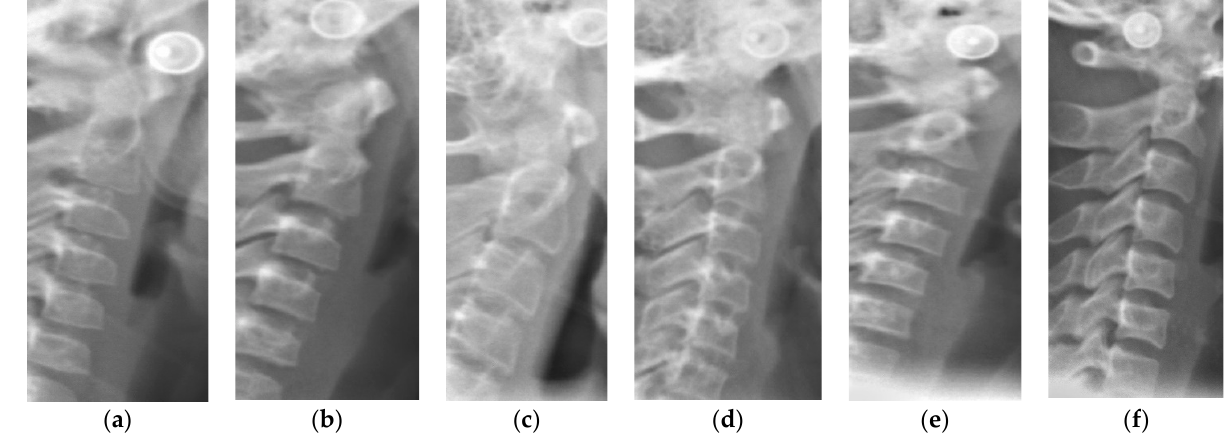
Figure 1. Schematic representation and examples of different cervical maturity stages. CVS: cervical vertebral staging. ( a ) CVS1: Flat lower borders of all the three vertebrae. Trapezoidal body of C3 and C4; ( b ) CVS2: Concavity present at the Lower border of C2. No change in shape of bodies of C3 and C4; ( c ) CVS3: Concavities present at Lower borders of both C2 and C3. C3 and C4 bodies may be either trapezoid or rectangular horizontal in shape; ( d ) CVS4: Concavities present at Lower borders of C2, C3, and C4. C3 and C4 bodies are rectangular horizontal in shape; ( e ) CVS5: Concavities present at Lower borders of C2, C3, and C4. Either one of the bodies of C3 and C4 has square shape others remain rectangular; ( f ) CVS4: Concavities present at the lower borders of C2, C3, and C4. At least one of the bodies of C3 and C4 attained rectangular elongated in shape and the bodies of the other cervical vertebra remain squared.